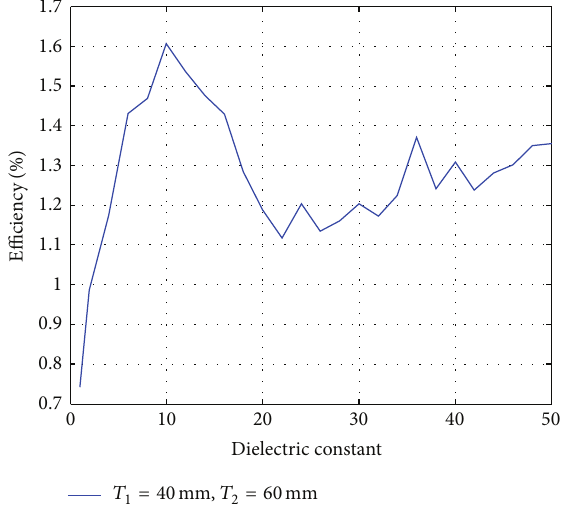
Figure 10: Antenna radiation efficiency with 𝑇 1 = 40 mm, 𝑇 2 = 60 mm at 403 MHz.